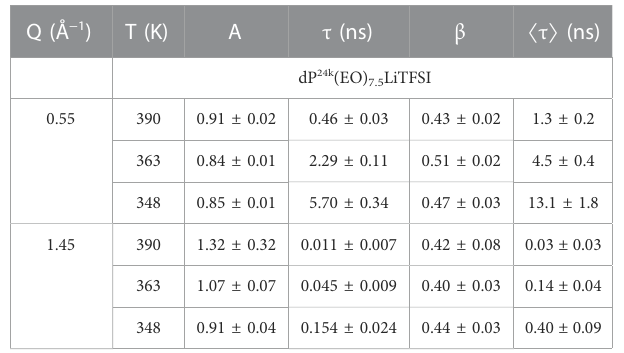
TABLE1Fitting results forthe ISFdataondP 24k (EO) 7.5 LiTFSI collected atNCNR. Uncertainties represent standard errors.